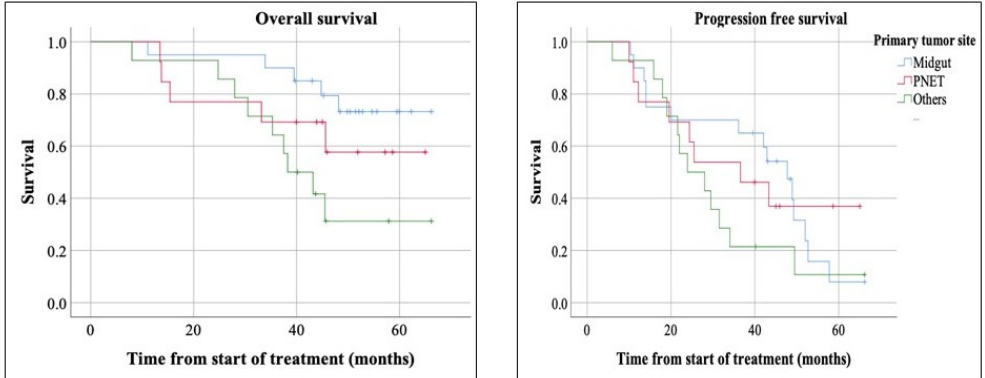
Figure 2. The overall survival did not reach median. The median progression free survival was 36.1 months. Curr. Oncol. 2020 , 1 , FOR PEER REVIEW